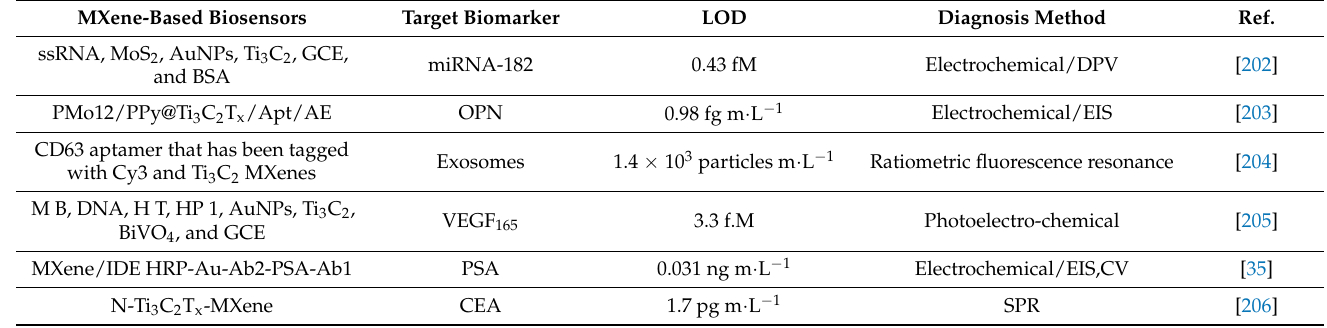
Table 4. SPR nanobiosensor-based SMQDs to detect cancer biomarkers.